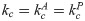
Mean concentrations of 1,2-PD and propionaldehyde in the MCP (PMCP; AMCP) and cytosol (Pcyto; Acyto) as a function of (A) kc when kc=kcA=kcP; (B) kcA when kcP=10−5 cm/s; and (C) kcP when kcA=10−5 cm/s. Saturation phase space of PduCDE and PduP/Q with respect to (D) kcA and kcP.In (A), (B), and (C), KM of PduCDE and PduP/Q are shown as solid lines. The baseline permeabilities are shown with a black dashed line. In (D), regions of saturation (concentration of substrate > KM of the appropriate enzyme) are plotted in blue when PduCDE and PduP/Q are saturated, orange when only PduCDE is saturated, and in grey when neither enzyme is saturated. Red solid lines indicate when Acyto is 1 μM; red dashed lines indicate when Acyto is 10 nM. Black dashed lines indicate the baseline parameter values used in the model of the Pdu MCP. Green line indicates kcA=kcP.